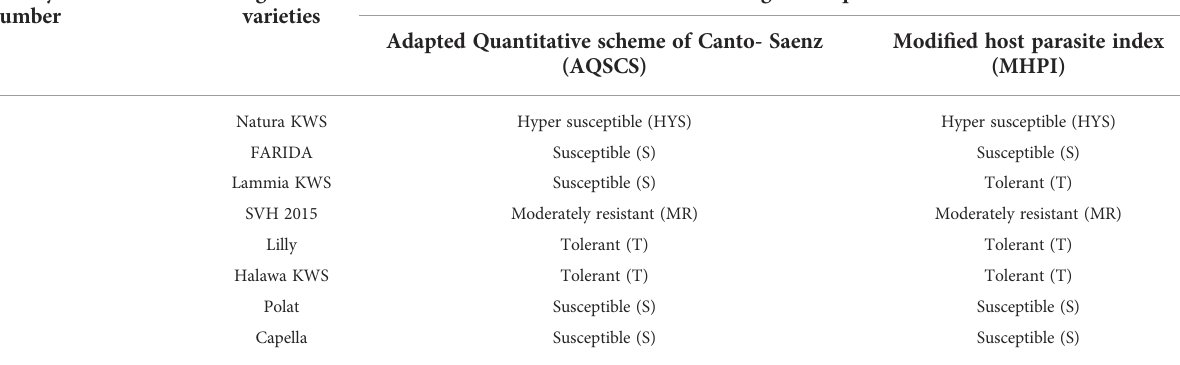
TABLE 8 Classi fi cation of different sugar beet (Beta vulgaris saccharifera) varieties according to susceptibility screening procedure for root-knot nematode, Meloidogyne